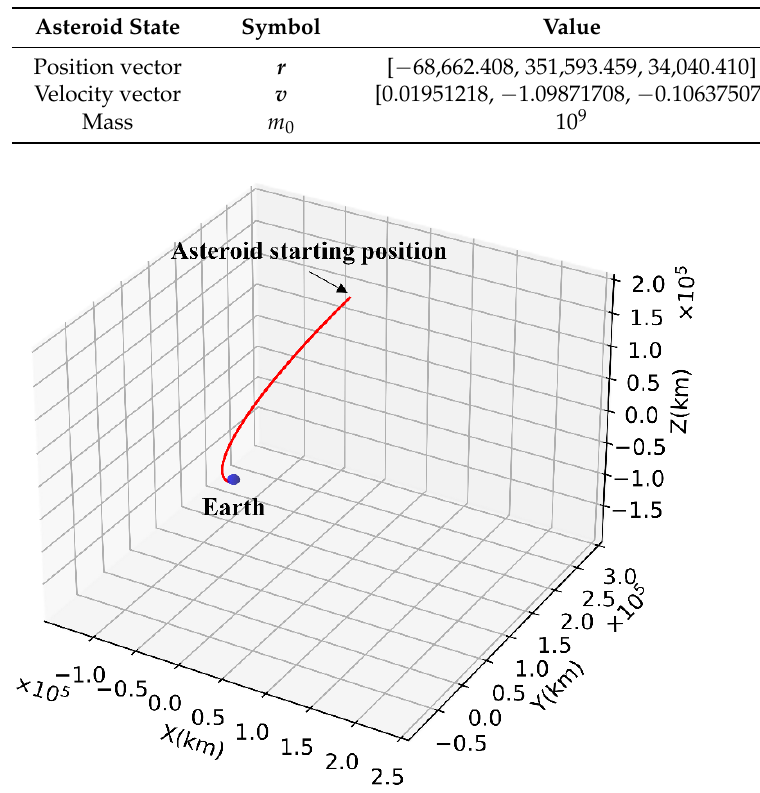
Table 2. The position and velocity vector of the asteroid.